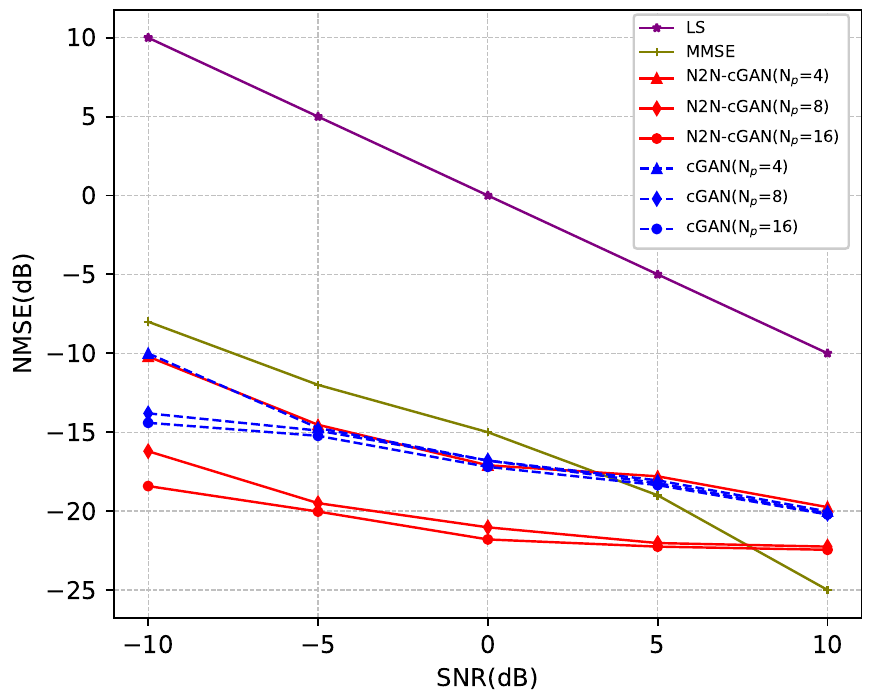
Figure 7. Comparison of the NMSE performance of N2N-cGAN and other algorithms at various